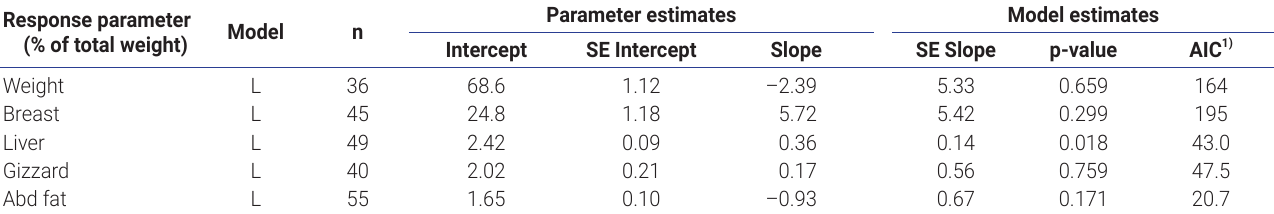
Table 3. Regression equation on the influence of flavonoid-rich herbs (in % of diet as fed) on carcass composition of